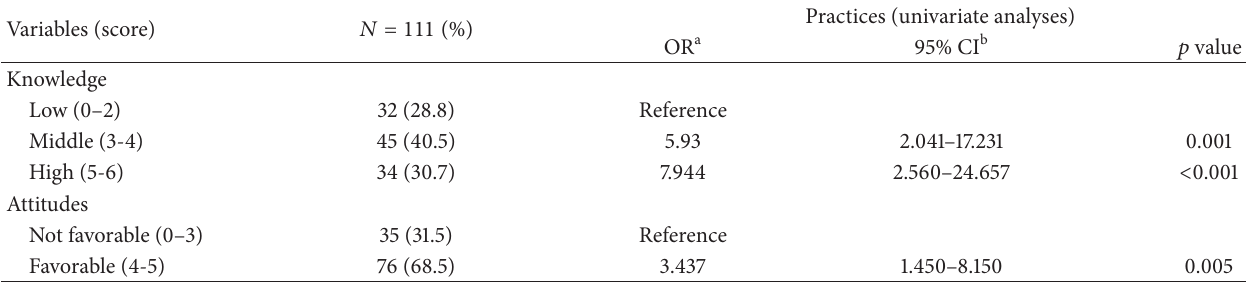
Table 4: Univariate logistic regression analyses about knowledge and attitudes with practices.